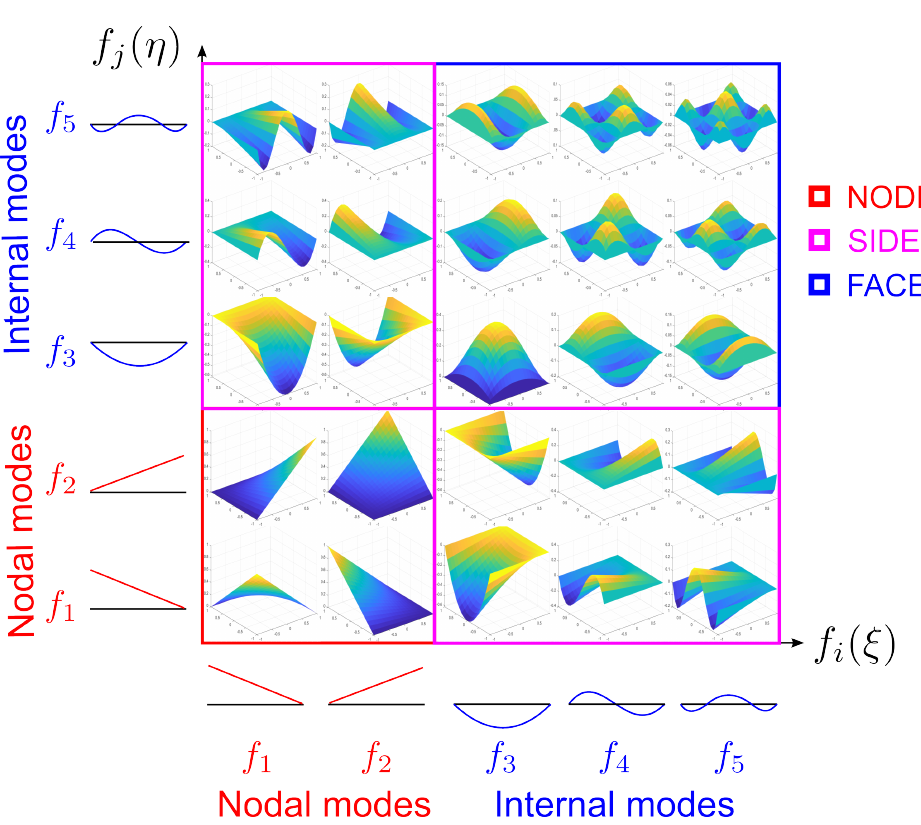
Figure 4. Two − dimensional shape